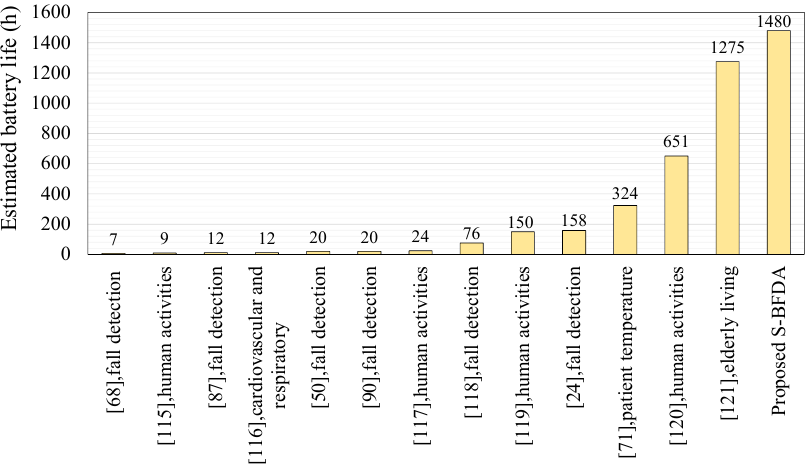
Figure 27. Comparison between battery life of the proposed S-BFDA and previous system.